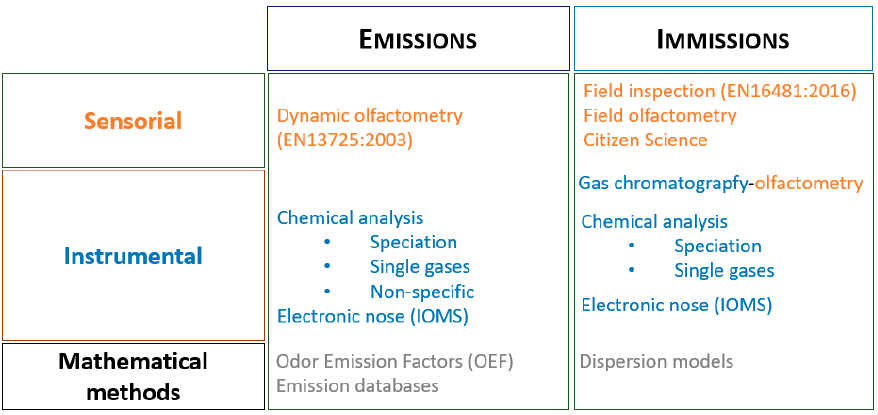
Figure 1. Schematization of odor impact assessment methods.